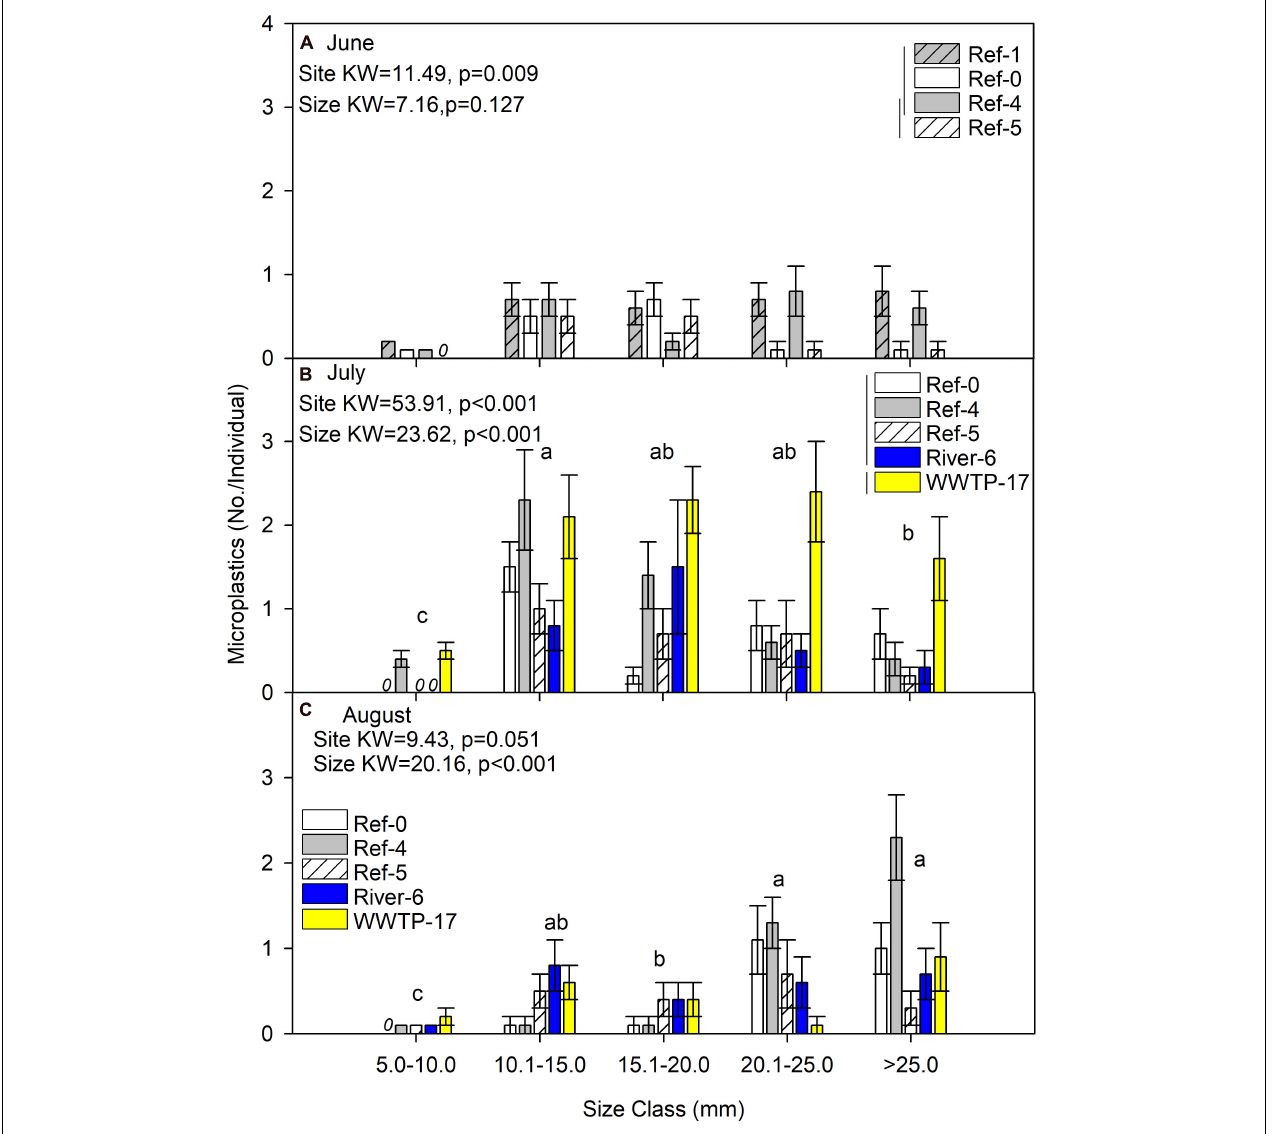
FIGURE 2 | Mean ( ± SE) microplastic abundance (No./individual) in dreissenid mussels from Milwaukee Harbor in (A) June, (B) July, and (C) August 2018. Kruskal–Wallis (K–W) test results are shown in each panel, where degrees of freedom (df) for size class = 4 in all panels, and df for site = 3 in panel (A) and df = 4 in panels (B,C) . In each panel, means with the same lowercase letter are not significantly different among size classes following post hoc comparisons ( p ≤ 0.05). Overlapping vertical lines next to the site legend are not significantly different after post hoc comparisons ( p ≤ 0.05). Ref, reference; WWTP, wastewater treatment